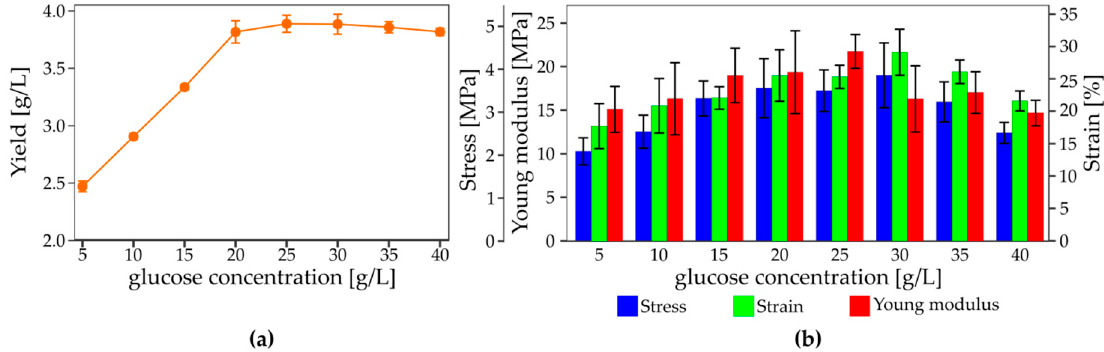
Figure 8. Impact of glucose concentration on ( a ) biosynthesis yield and ( b ) tensile parameters of bacterial nanocellulose.